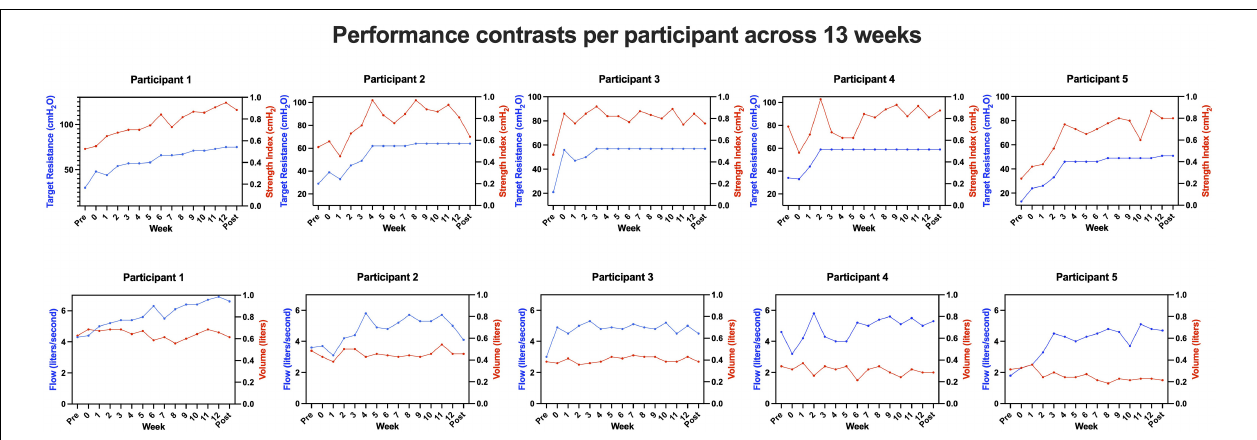
FIGURE 2 | Inspiratory muscle training (IMT) device data for each participant per week. Note the fluctuations in strength index (top panel, right y -axis, red) despite the flattening of the curve of the target resistance (top panel, left y -axis, blue) for participants 2–5. Only for participant 1, there was a steady increase in both measures over the entire course of the intervention. The pattern of the flow curve (bottom panel, blue) corresponds to the pattern of the strength index (top panel, red). For better visualization of the different scales, both are depicted in separate graphs. The volume curve (bottom panel, red) shows less fluctuations and no overall gain across the training